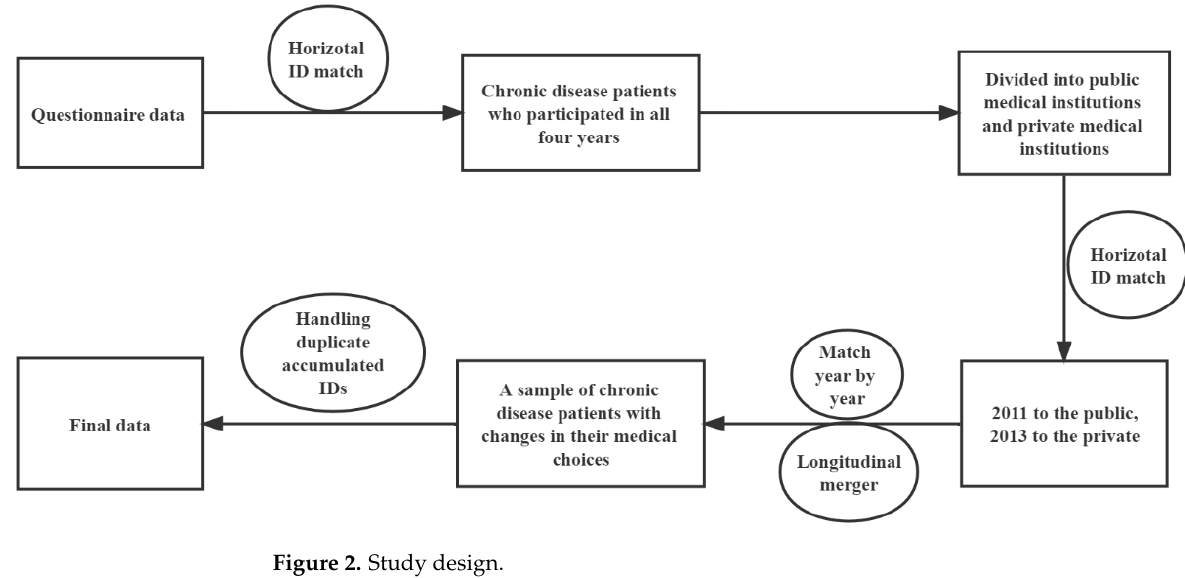
Figure 2. Study design.